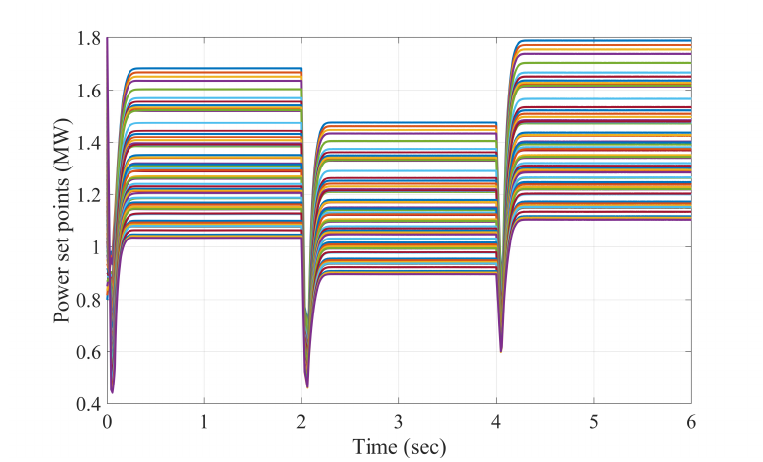
Figure 2. Evaluation of the power set points for Princess Amalia wind farm.